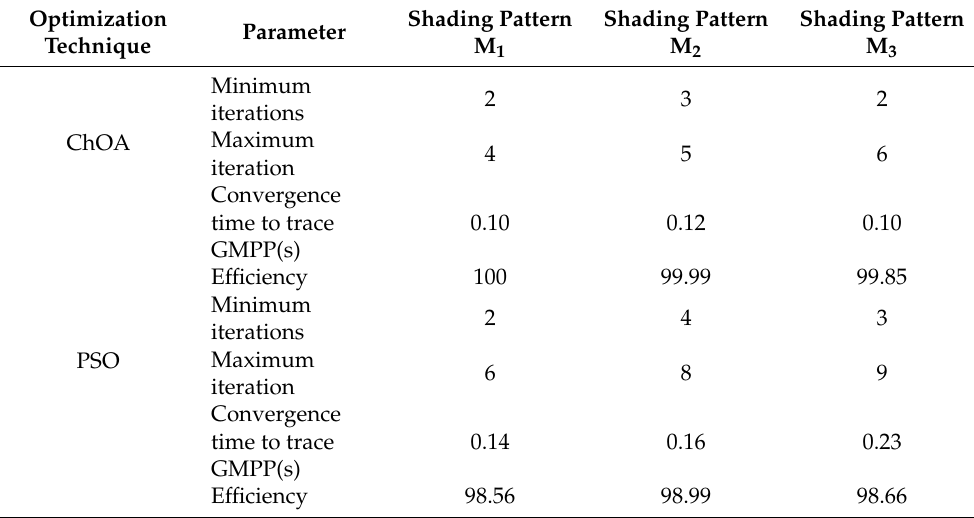
Table 8. Comparison of statistical results of ChOA and PSO simulation analysis.